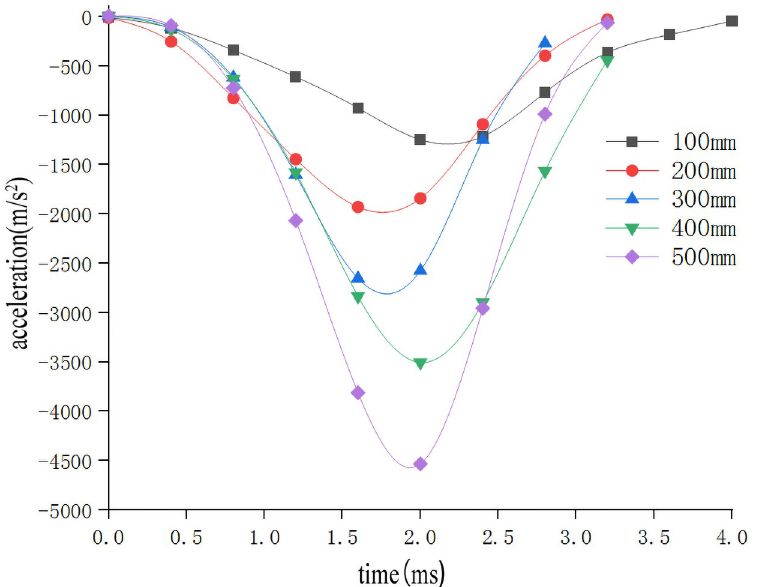
Fig 6. Acceleration-time relationship during drop impact at different heights.